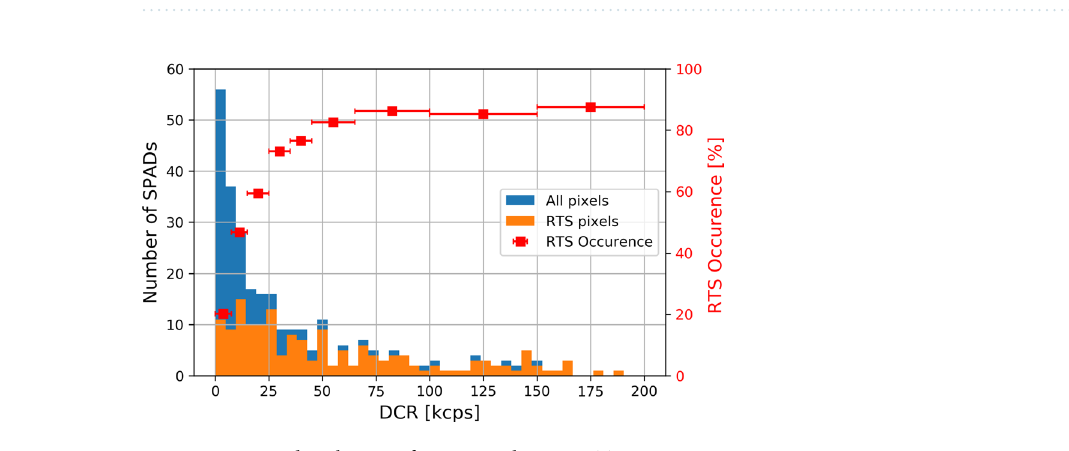
Figure 8. DCR distributions for SPADs showing RTS.